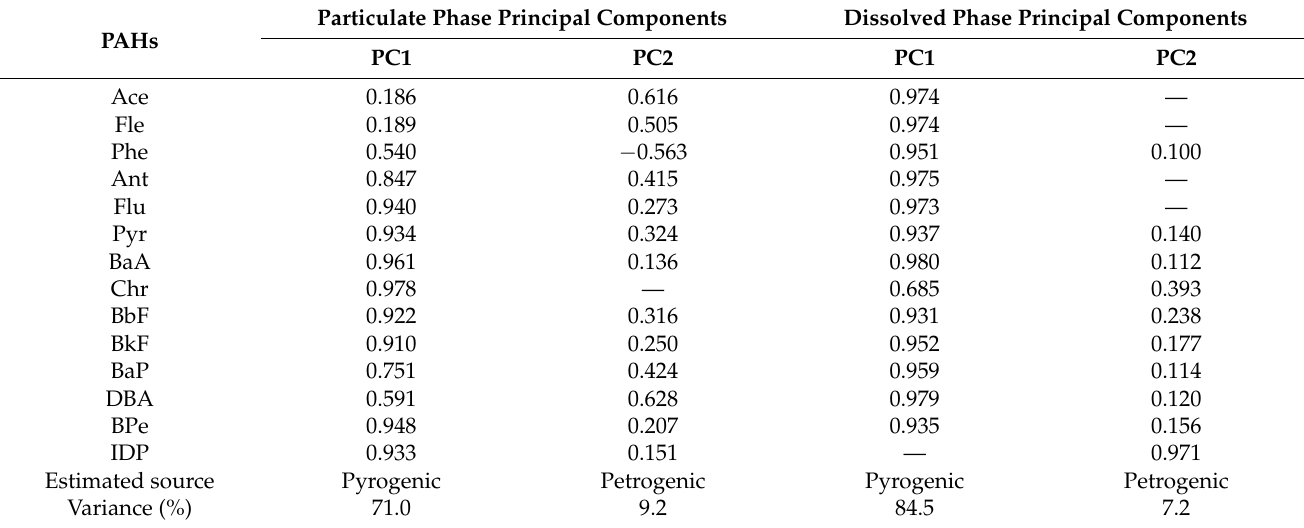
Table 3. Varimax normalized matrix of 14 PAHs in particulate and dissolved phase